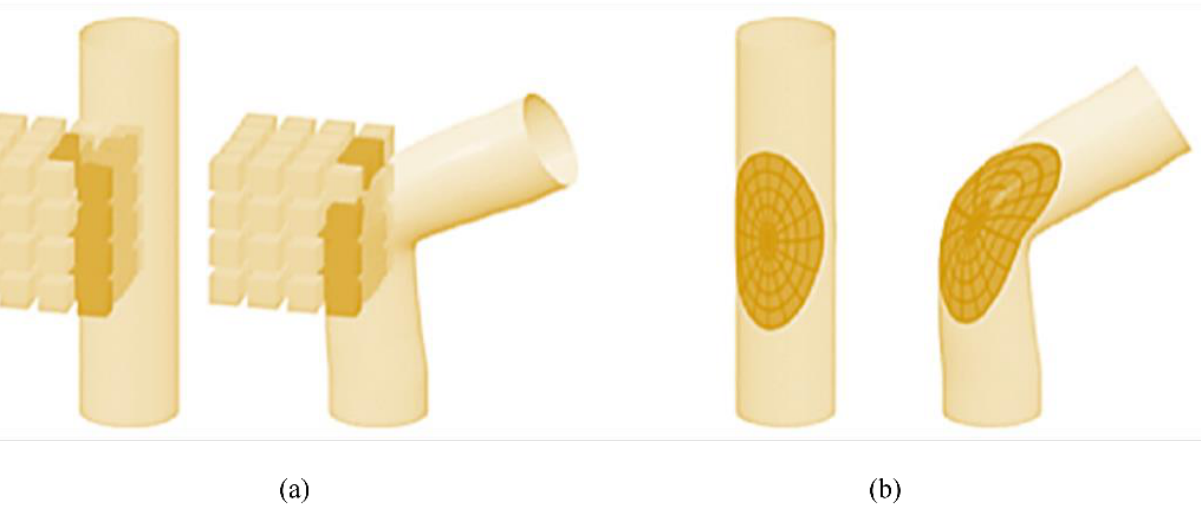
Figure 8. Illustration of deep learning approaches on geometric data. ( a ) Extrinsic method and ( b ) intrinsic method.